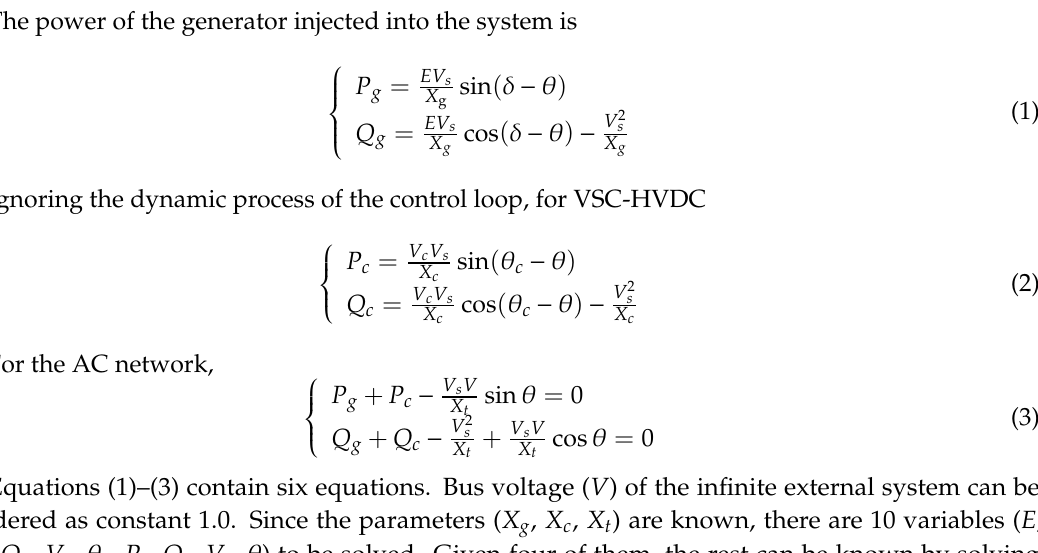
Figure 2. Single machine infinity equivalent system with VSC-HVDC.